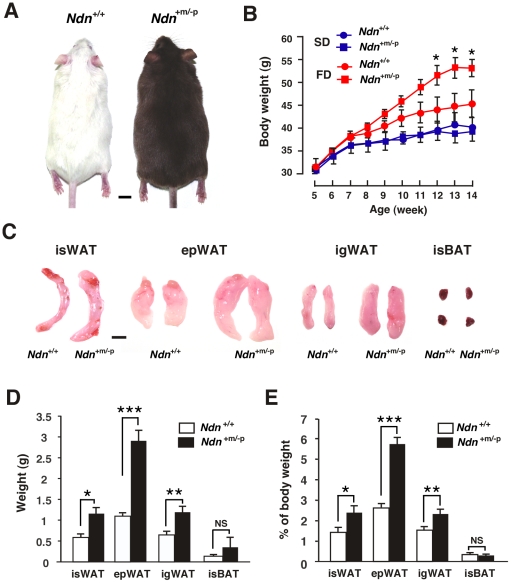

Ndn
+m/−p mice exhibit enhanced adipose expansion.(A) Representative wild-type (Ndn
+/+, left) and paternal Ndn-mutated (Ndn
+m/−p, right) littermates. Mice were fed the high-fat diet from 5 to 14 weeks of age. Note that Ndn
+m/−p mice carrying mutated Ndn linked to wild-type pink-eyed dilution gene exhibit a brown-hair phenotype on the ICR background. (B) Body weight curves of mice fed standard (SD) or high-fat diet (FD). Mouse body weight was measured weekly from 5 to 14 weeks of age (mean ± SEM, n = 5–8 for each group). *P<0.05, Ndn
+m/−p vs. Ndn
+/+ using one-way ANOVA and Tukey's post hoc test. (C) Representative fat pads removed from high-fat-fed littermates. isWAT, interscapular WAT; epWAT, epididymal WAT; igWAT, inguinal WAT; isBAT, interscapular BAT. (D, E) Fat pad weight. Absolute (D) and relative values (E) are shown (mean ± SEM, n = 3–5). *P<0.05, **P<0.01, ***P<0.001. NS, not significant (P>0.05). Scale bars, 1 cm (A, C).